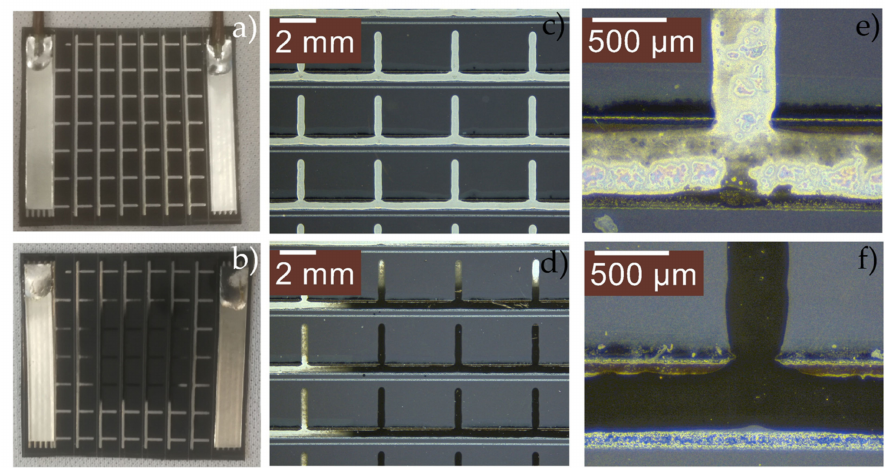
Figure 13. Degradation of a sample of material combination 1 (Table 2): ( a ) before the atomic oxygen test; ( b ) after the test, the sample was exposed to an atomic oxygen beam, restricted to a central 10 mm × 10 mm area; ( c ) undisturbed silver grid before the test; ( d ) degraded silver grid after the test; ( e ) partially degraded silver contact; ( f ) fully degraded silver contact.